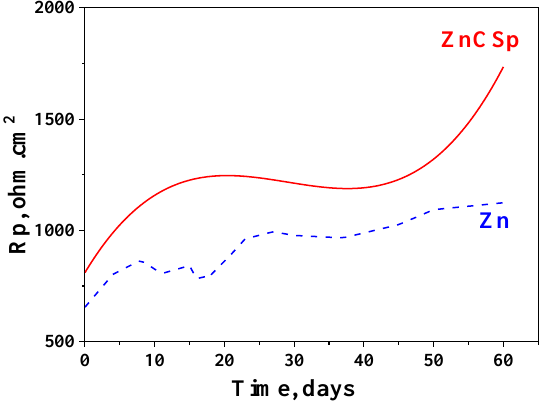
Figure 3. Surface morphology of zinc–carbon sphere coating on steel. Inset: carbon sphere at high magnification.